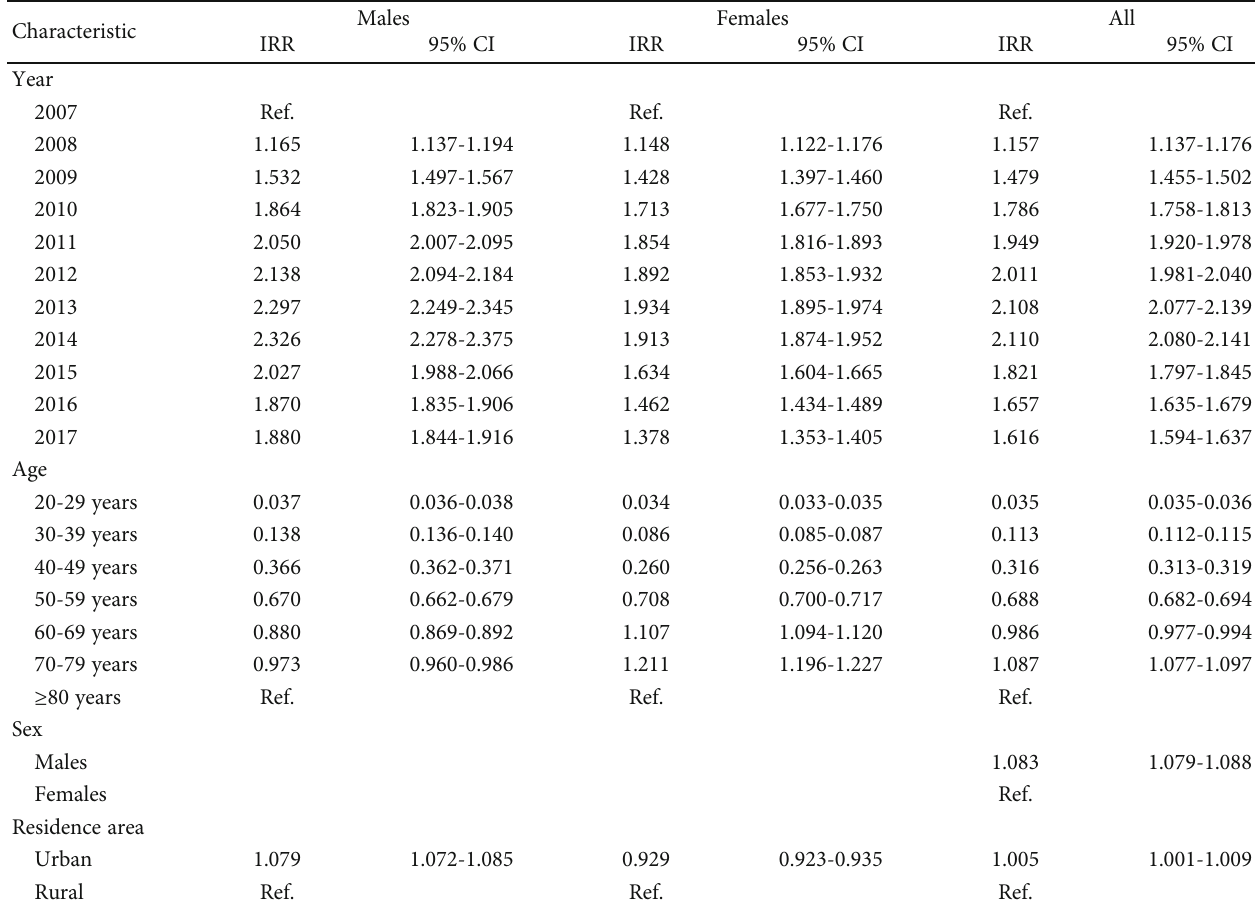
Table 3: Incidence rate ratios (IRR) of type 2 diabetes in relation to calendar year and demographic factors.